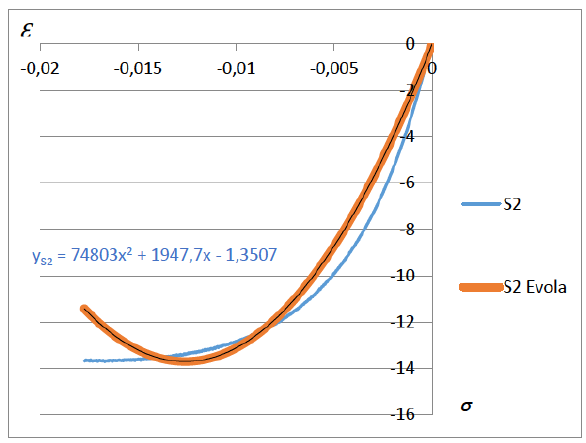
Figure 13: S2 Evola function compared to S2 (from researches)